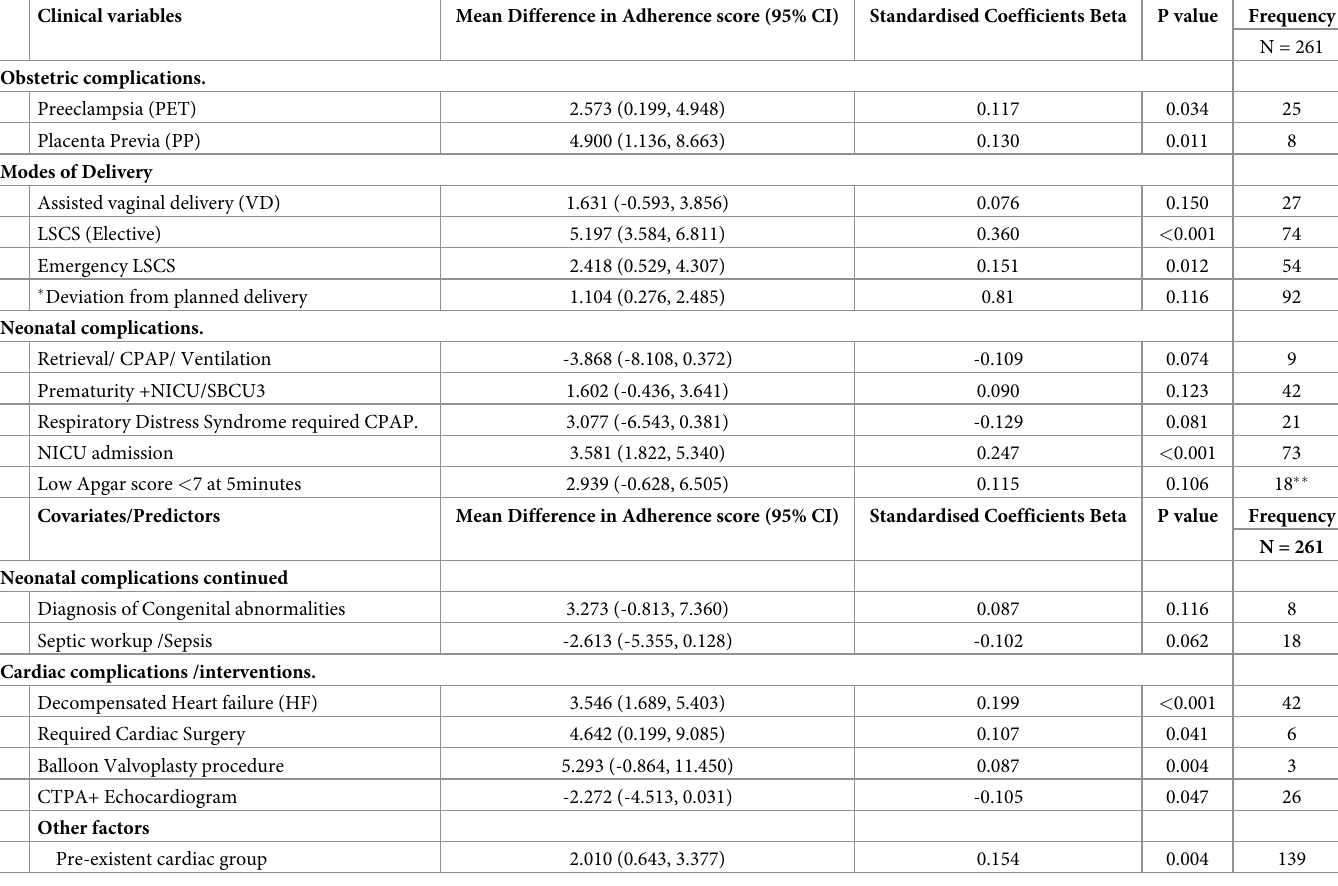
Table 5. Multivariable linear regression model results: Clinical variables versus adherence score of the clinical practice guidelines for South Australian pregnant women with cardiac conditions between 2003 and